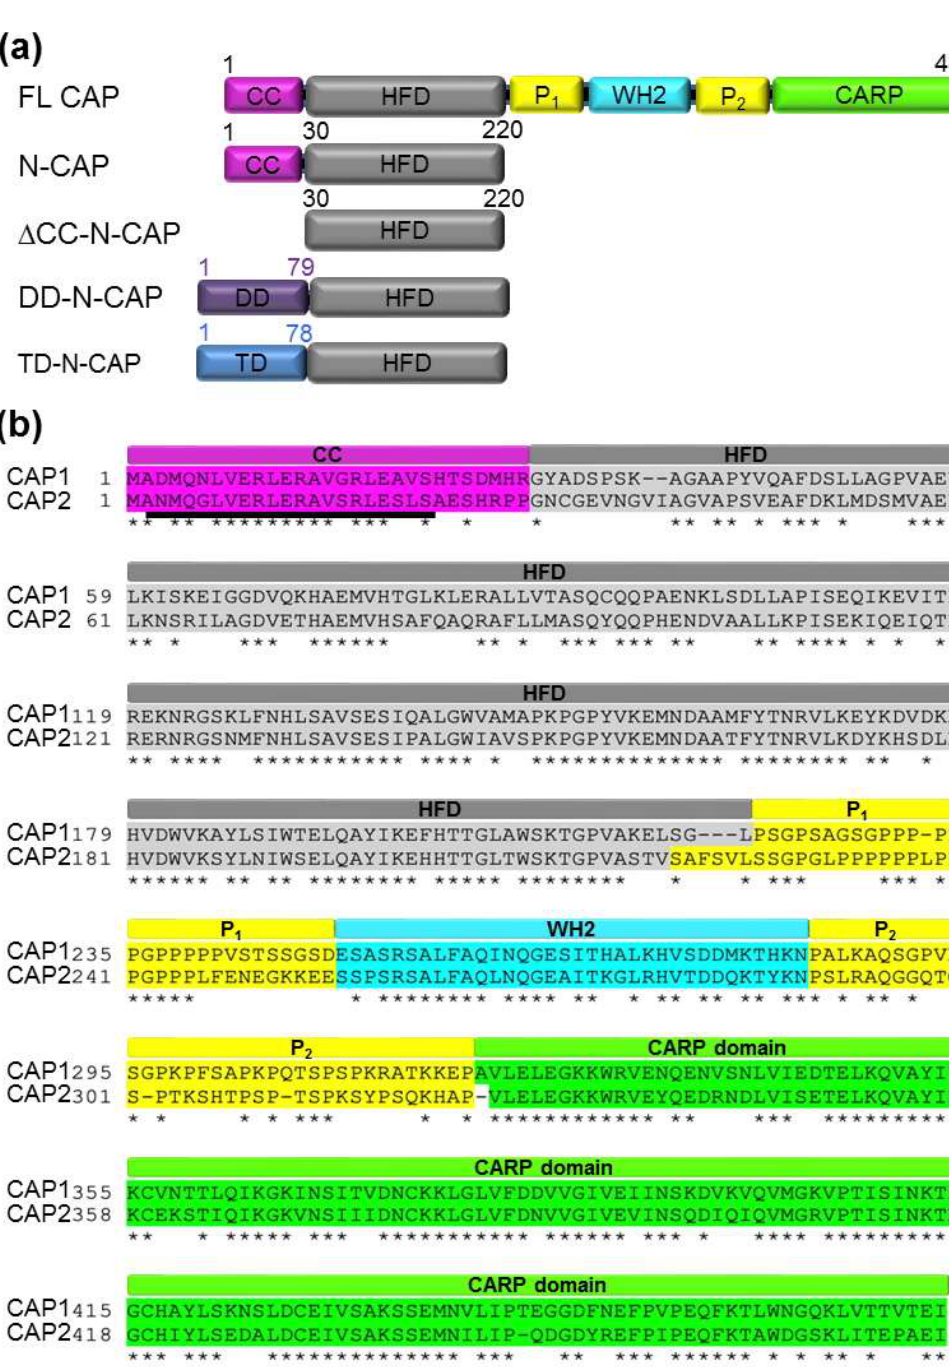
Figure 1. Domain structure of CAP proteins: ( a ) schematic representation of the full-length (FL) CAP domain structure and the truncation constructs used in this study. Amino acid numbering is shown for CAP1 only. CC: coiled coil domain (pink); HFD: helical folded domain (grey); P 1 and P 2 : polyproline-rich regions (yellow); WH2: Wiskott-Aldrich syndrome protein (WASP)-homology 2 domain (cyan); CARP: C-terminal β -sheet domain (green); DD: dimerization domain; TD: trimerization domain. ( b ) Protein sequence alignment of human CAP1 and CAP2. Asterisks represent identical residues (64.1% identity) between the two isoforms. The underlined sequence with a predicted high helical propensity was used in CCBUILDER 2.0 for modeling coiled-coil oligomerization (see Figure 3). Domain abbreviation and coloring as in (a).